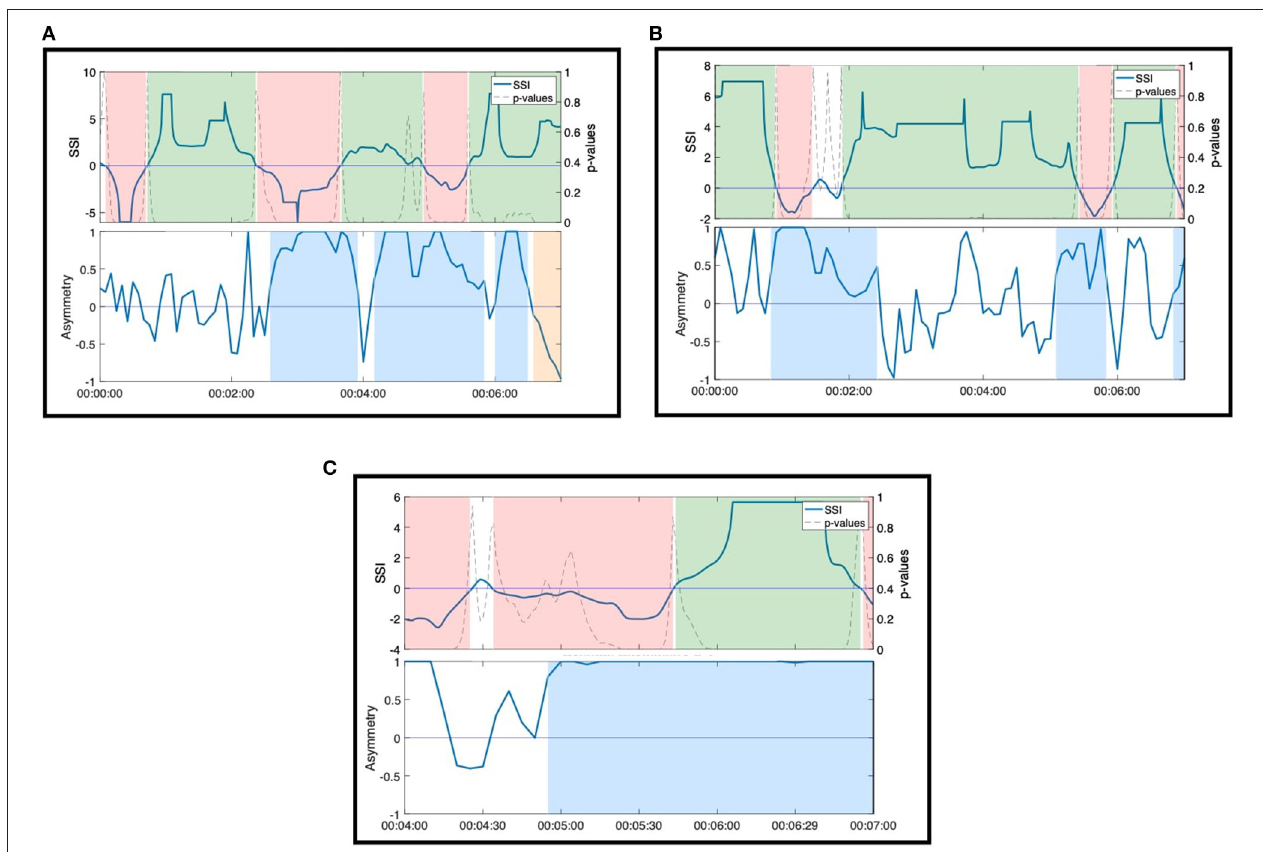
FIGURE 8 | Moments of significant SSI and sustained NSTE asymmetry during non-dyadic interactions in the musical textures activity. (A) Anne and Erica. (B) Ruth and Harvey. (C) Jean and